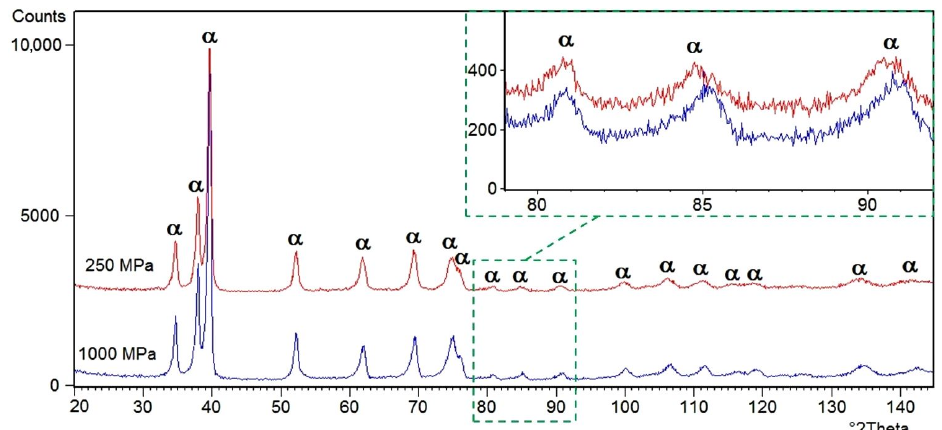
Figure 2. X-ray diffraction patterns of the material prepared with using different pressure during Figure 2. X-ray di ff raction patterns of the material prepared with using di ff erent pressure production. during